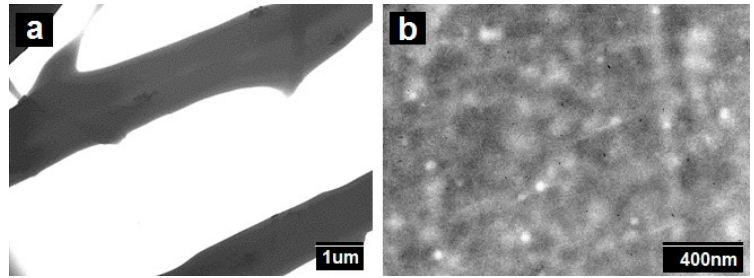
Figure 4. Scanning electron microscopy (TEM) images taken ( a ) directly on electrospun polycaprolactone (PCL) fibers containing palladium nanoparticles (PdNPs) and on ( b ) microtomed sections of their corresponding annealed film.